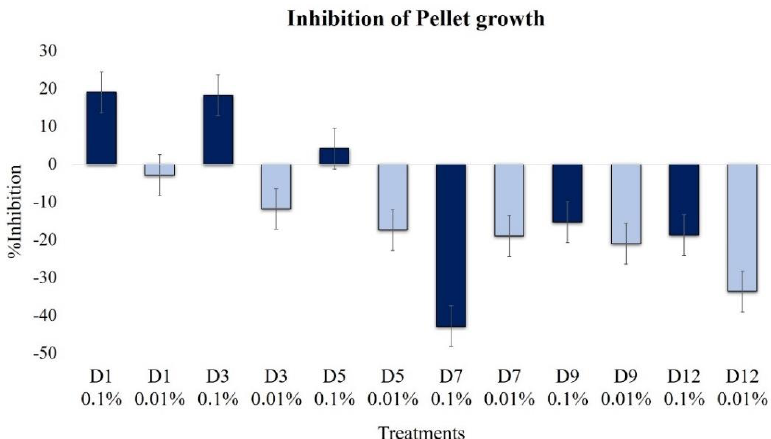
Figure 5. Effects of extracts at 0.1% (dark blue bars) and 0.01% (light blue bars) on B. cinerea pellet growth (1 × 10 4 conidia mL − 1 , 30 h incubation, 100 rpm, 24 ◦ C, light 12 h). The pellet diameters did not show a normal distribution; therefore, nonparametric Kruskal–Wallis analysis was performed. Data on the size of the filamentous region of pellets were subjected to arithmetic transformation with the square root function for the comparison of